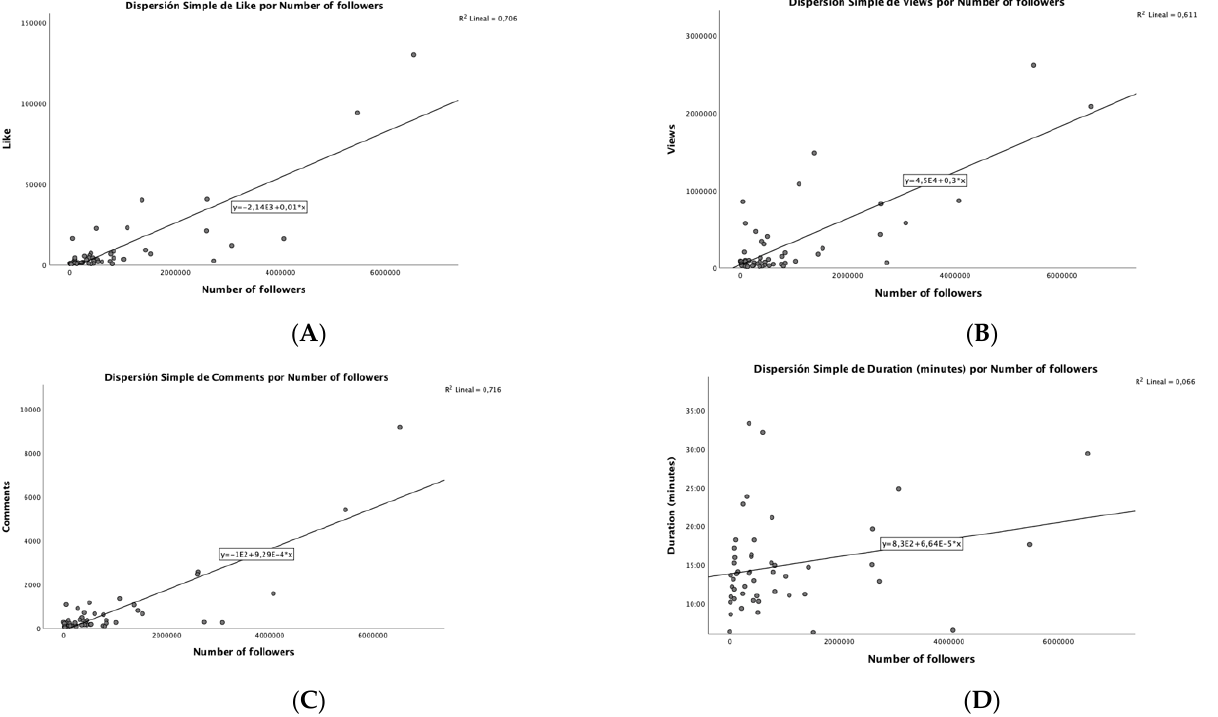
Figure 3. Dispersion diagrams of correlation between n followers and interactions. Note: From up to bottom and left to right: ( A ) dispersion between n likes and n followers; ( B ) dispersion between n views and n followers; ( C ) dispersion between n comments and n followers; ( D ) dispersion between duration (in minutes) and n